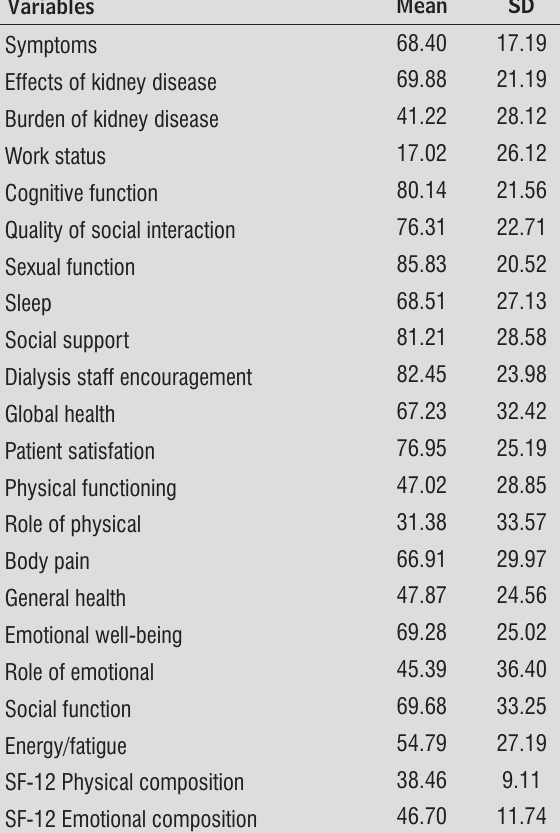
Table 2 - Characteristics of the dimensions of the